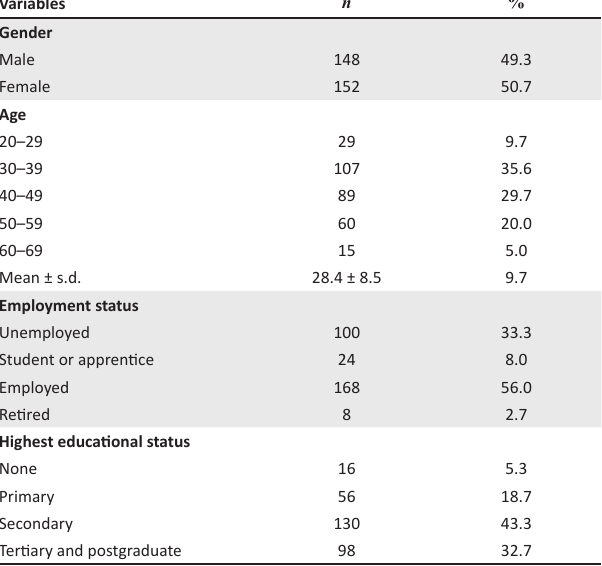
FIGURE 1: Flow diagram illustrating the recruitment process. TABLE 1: Socio-demographic profile of participants ( N =